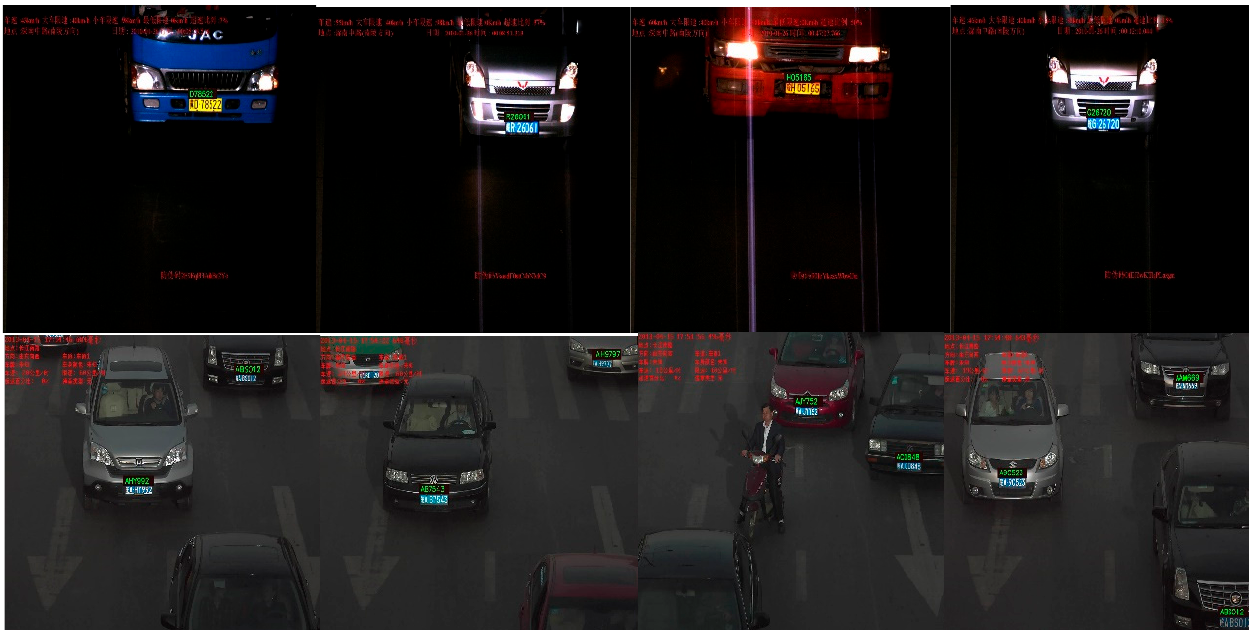
Figure 4. The LP recognition on different images of the PKU dataset.